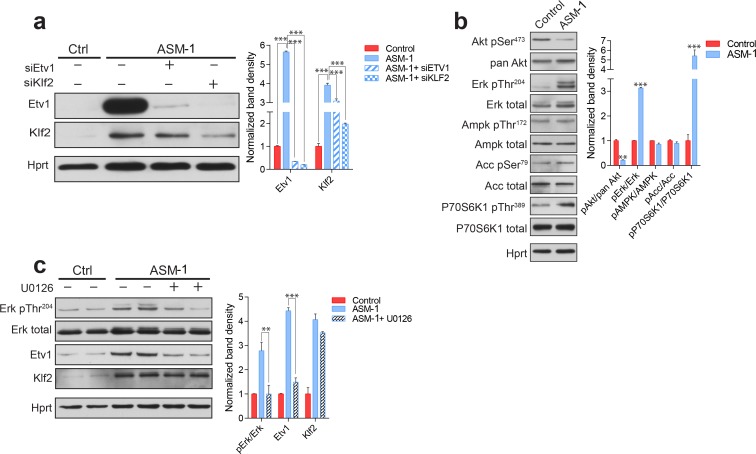
ETV1 up-regulation is dependent on KLF2 and ERK.(a) Silencing of KLF2 in ASM-deficient fibroblasts results in reduced levels of ETV1, shown by a representative western blot of whole cell extracts, with quantification of band densities (mean ± s.e.m, n = 3) in adjacent plots. One way ANOVA p-values ***p<0.001. (b) ASM-deficient fibroblasts show increased ERK and mTORC1 activities, reduced AKT activity and unchanged AMPK activity, as shown by a representative western blot of whole cell extracts with band density quantification presented in the adjacent plot as mean ± s.e.m., n = 3. T-test p-values **p<0.01 ***p<0.001 (c) ERK inhibition by treatment with U0126 (20 µM, 16 hr) in ASM-deficient fibroblasts results in reduced ETV1 levels but does not affect KLF2, as shown by a representative western blot, with band density quantification in the adjacent plot depicted as mean ± s.e.m. for biological triplicates. T-test p-values **p<0.01 ***p<0.001.